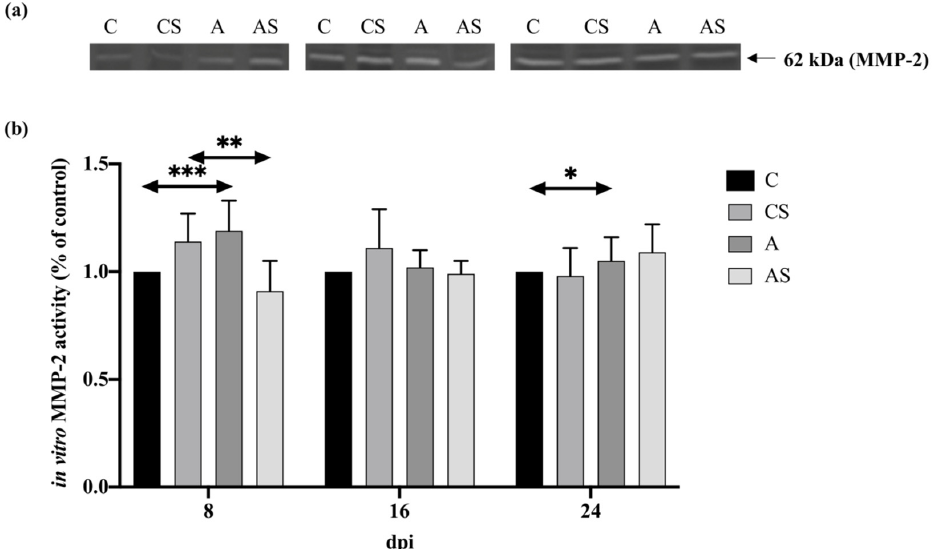
Figure 4. Activity of matrix metalloproteinases-2 (MMP-2) in the kidneys of mice infected with Acanthamoeba spp. MMP-2 was determined using zymography. Representative zymography ( a ) and densitometric analysis of MMP-2 protein ( b ) in mouse kidneys were shown. Data represent the means ± standard deviation for six independent experiments. (A: Immunocompetent mice infected with Acanthamoeba spp.; AS: Immunosuppressed mice infected with Acanthamoeba spp.; dpi: Days post Acanthamoeba spp. infection; C: Immunocompetent mice uninfected with Acanthamoeba spp.; CS: Immunosuppressed mice uninfected with Acanthamoeba spp.; statistically significant differences * p < 0.05; ** p < 0.01; *** p < 0.001).